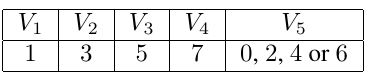
Tab. 1: Target arity for partition